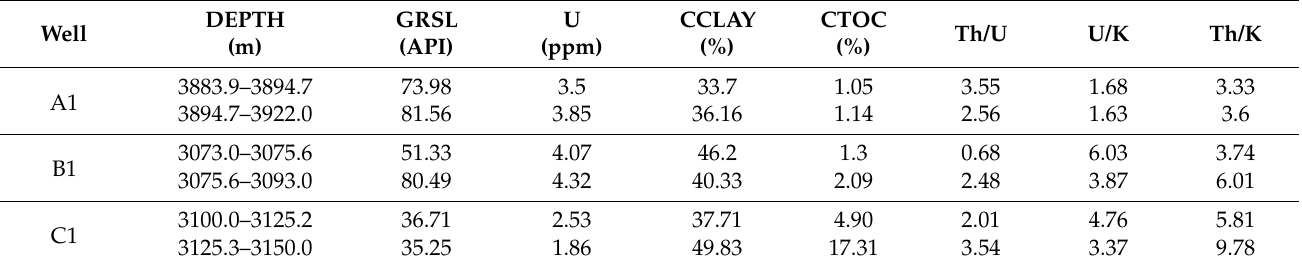
Table 4. Logging characteristics of shale reservoirs in wells A1, B1, and C1.